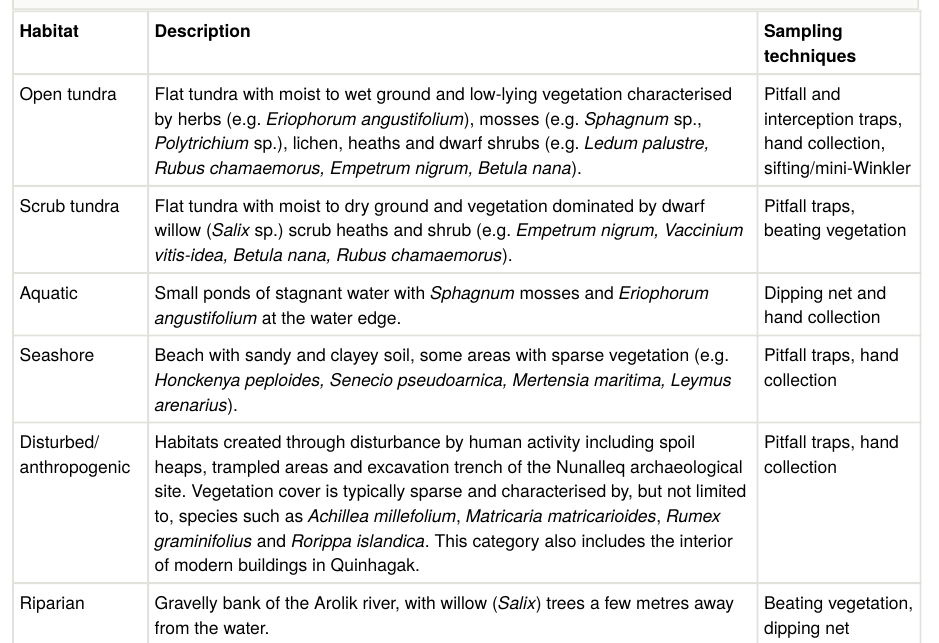
List and description of the di ff erent habitats sampled in the vicinity of the Nunalleq archaeological Habitat Description Sampling